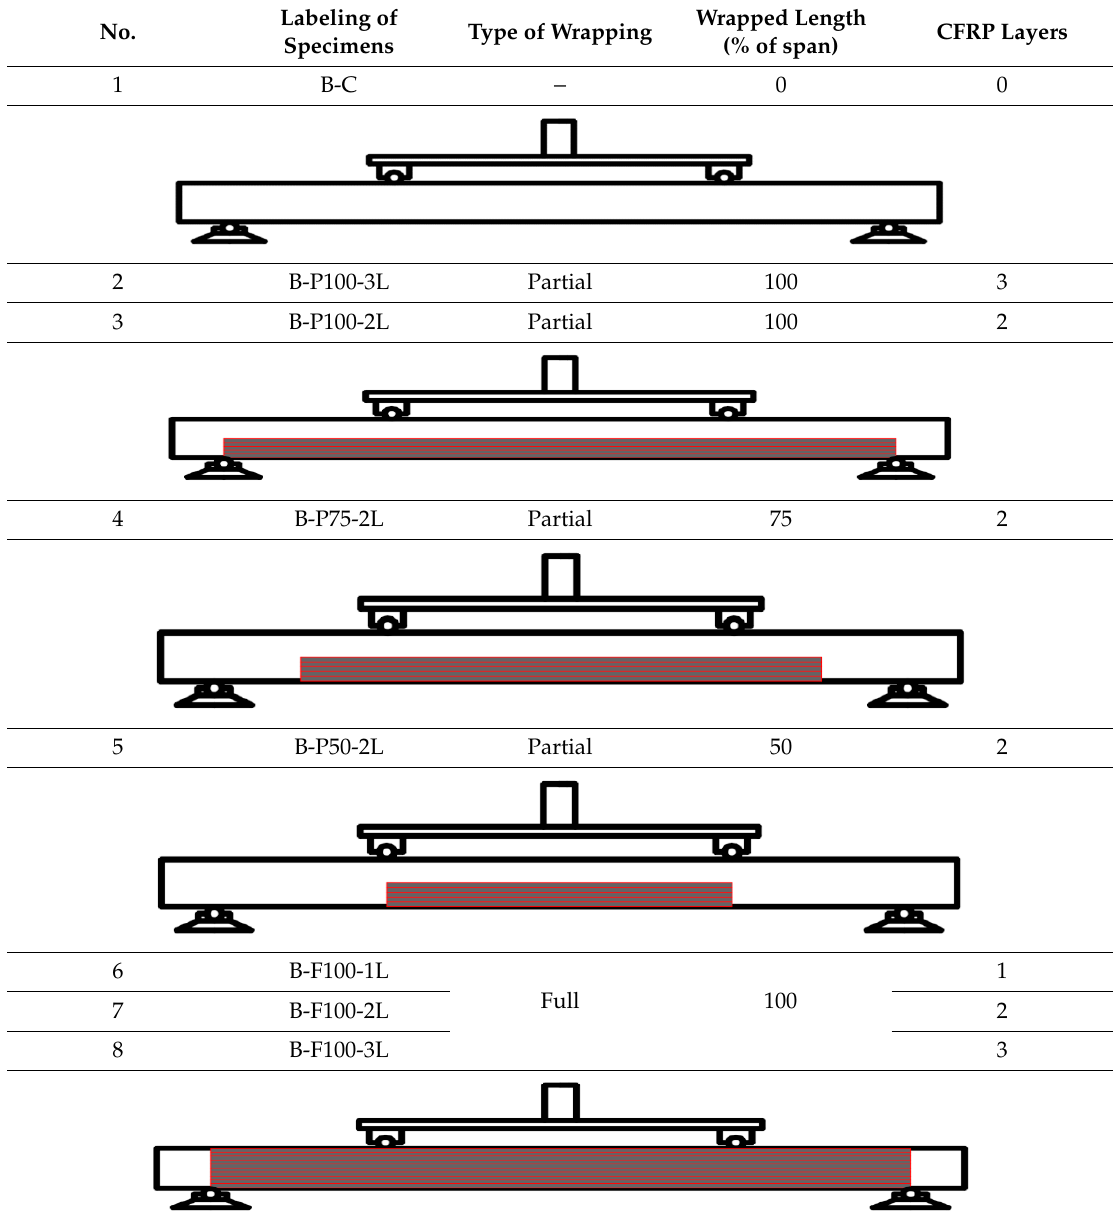
Figure 3. CFRP wrapping sheets: ( a ) partial wrapping scheme for HPCFDST beams, ( b ) full wrapping scheme for HPCFDST beams. Table 4. Labeling of HPCFDST beams strengthening with CFRP sheets.